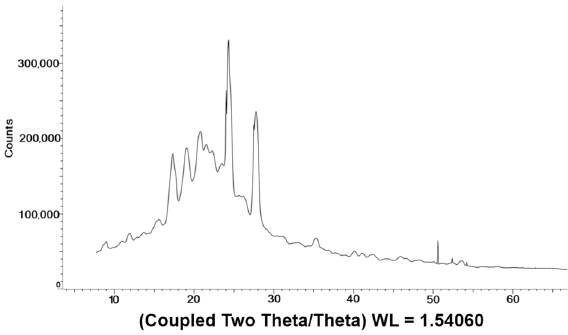
Figure 6. Powder X-ray diffraction (XRD) results for the benzocaine sample.